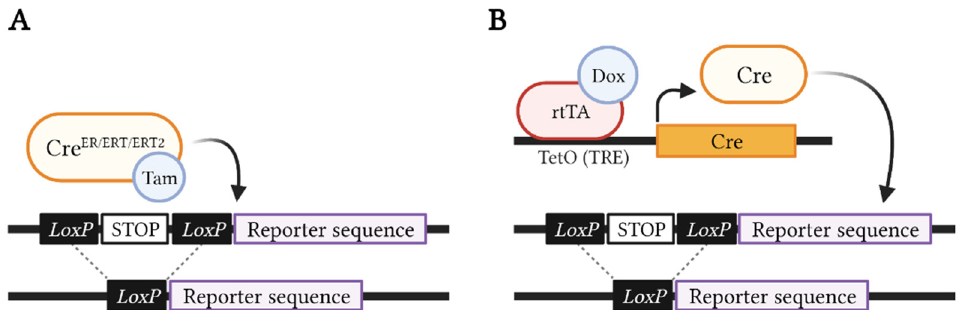
Figure 3. Inducible Cre/Lox systems. ( A ) Tamoxifen-inducible Cre/Lox model, where, upon tamox- ifen (Tam) administration, the cells expressing CreER, CreERT, or CreERT2 (determined by a specific promoter) will be labeled with β -galactosidase, fluorescent protein(s), or barcode sequence(s) due to the Cre-mediated recombination of the loxP sites, excising the STOP codon in the reporter transgene. ( B ) Tetracycline-inducible Tet/Lox system, where, upon doxycycline (Dox) administration, the cells expressing rtTA will be labeled by the chosen reporter due to the binding of the rtTA transactivator to TRE sequences (such as transcriptional activation elements (TetO)), resulting in Cre expression and consequent excision of the loxP -flanked STOP codon upstream to the reporter transgene. This figure was created with Biorender.com (accessed on 12 December